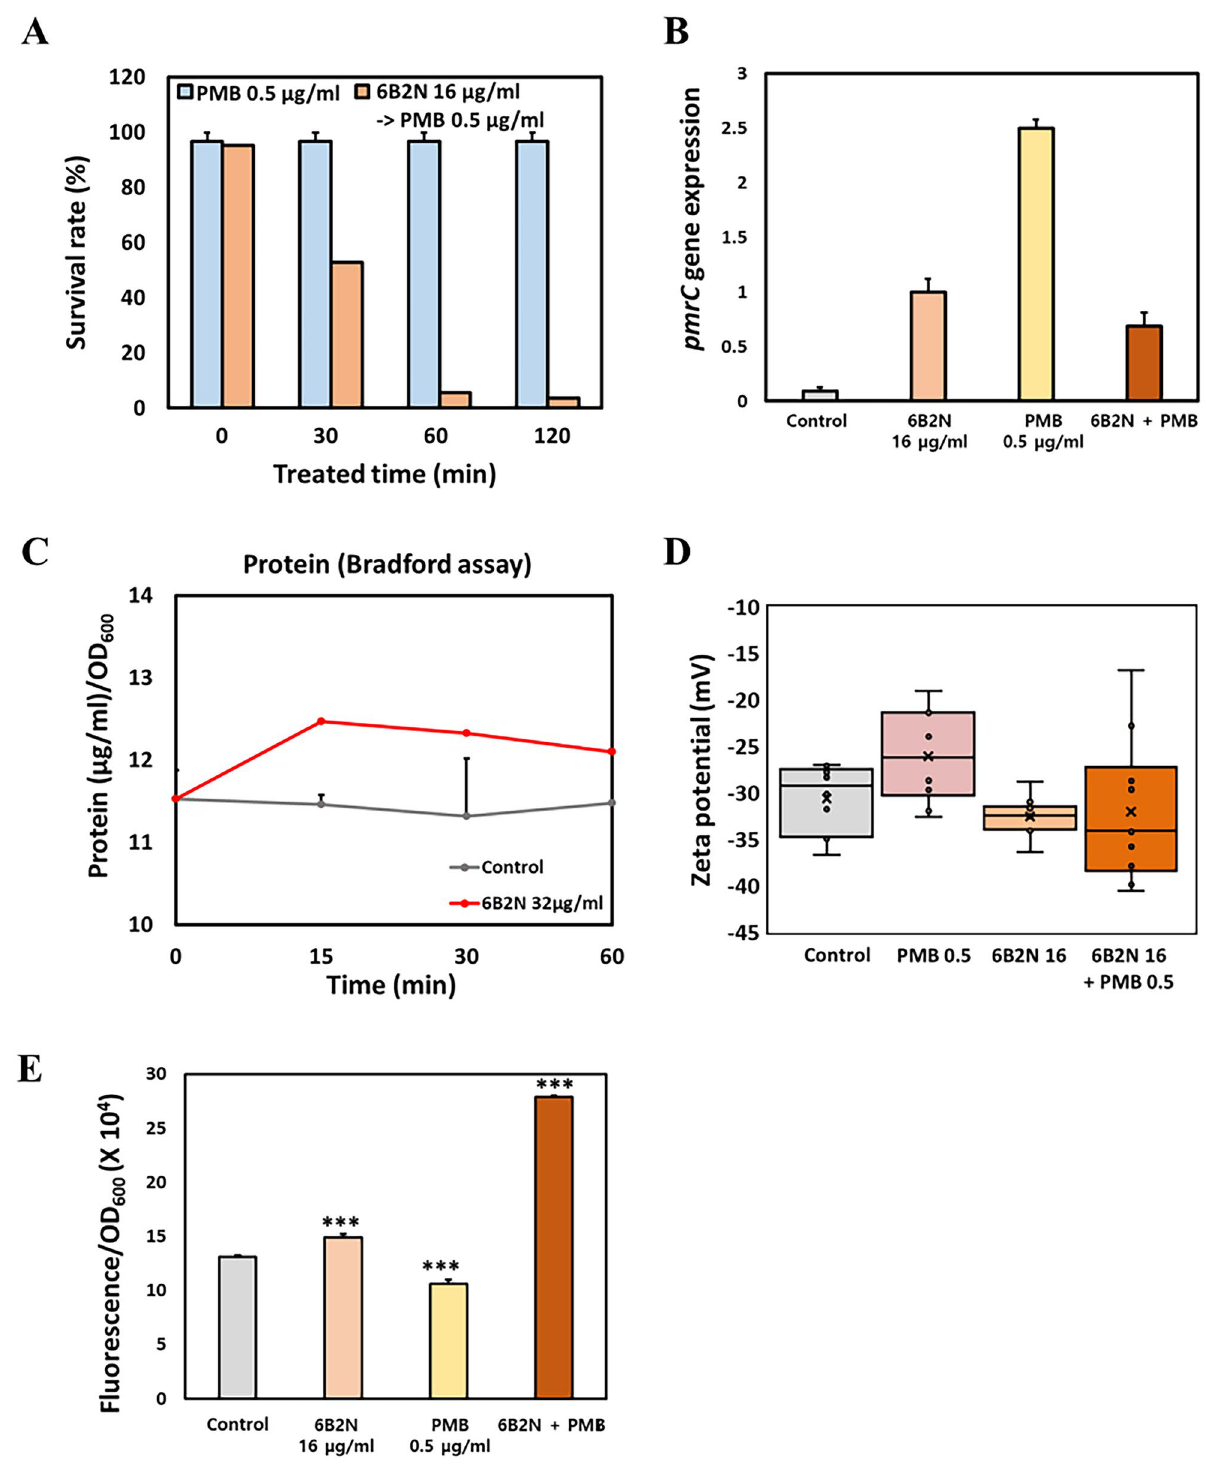
Figure 5. Mechanisms of synergistic effect on A. baumannii ATCC17978 treated with 6-bromo-2-naphthol. ( A ) Induction test using 6-bromo-2-naphthol. ( B ) Changes in the expression level of pmrC . ( C ) The concentration of protein in the supernatant of A. baumannii treated with only 6B2N. The concentration of 6B2N was set at 16 μg/mL. ( D ) The surface zeta potential of A. baumannii after treatment with 6B2N. ( E ) Assessment of changes in cellular permeability using ANS dye. Statistical analysis was performed using Student’s t-test (* P < 0.05, *** P <